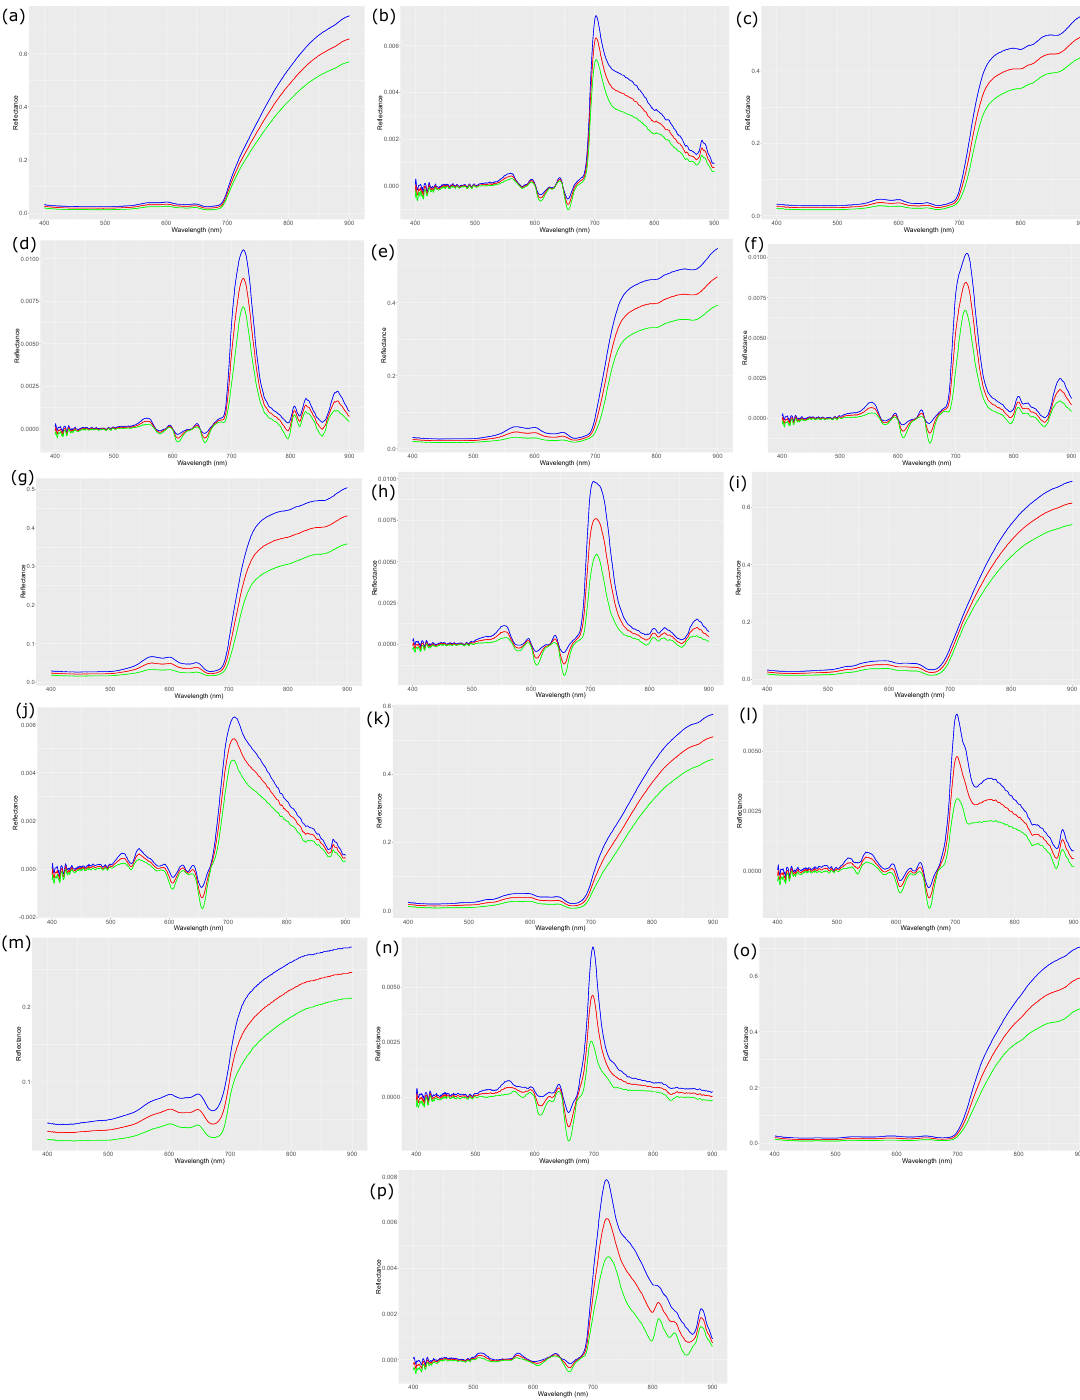
Figure A1. Spectral outputs for each species, red = mean, blue = mean + 1SD, green = mean − 1SD: ( a ) Alaria esculenta raw. ( b ) Alaria esculenta 1st derivative. ( c ) Fucus serratus raw. ( d ) Fucus serratus 1st derivative. ( e ) Fucus spiralis raw. ( f ) Fucus spiralis 1st derivative. ( g ) Fucus vesiculosus raw. ( h ) Fucus vesiculosus 1st derivative. ( i ) Laminaria saccharina raw. ( j ) Laminaria saccharina 1st derivative. ( k ) Laminaria sp raw. ( l ) Laminaria sp 1st derivative. ( m ) Laminaria sp stipe raw. ( n ) Laminaria sp stipe 1st derivative. ( o ) Ulva lactuca raw. ( p ) Ulva lactuca 1st